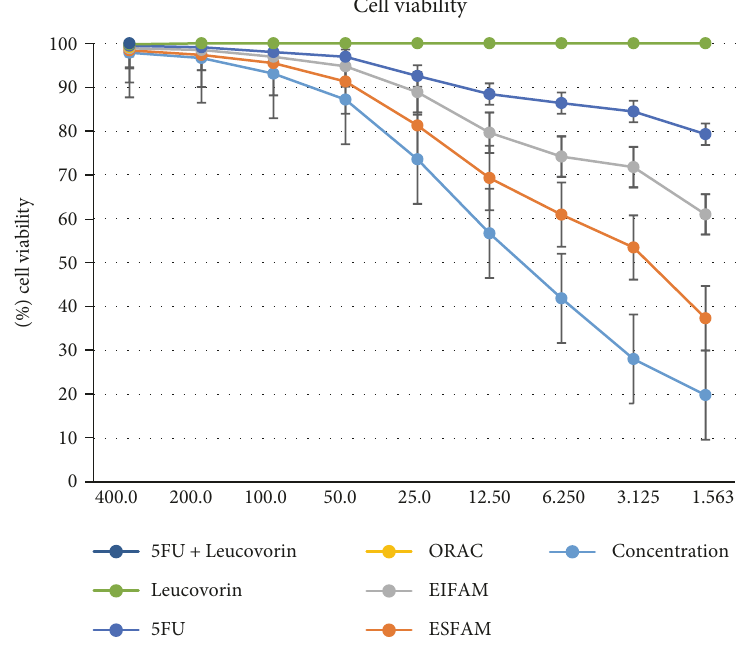
Figure 1: COLO-205 cell lines were treated with ESFAM, EIFAM, leucovorin, and 5FU for 48 h. Cell viability was determined using MTT assay. The results represent the mean ± SD of three independent experiments.